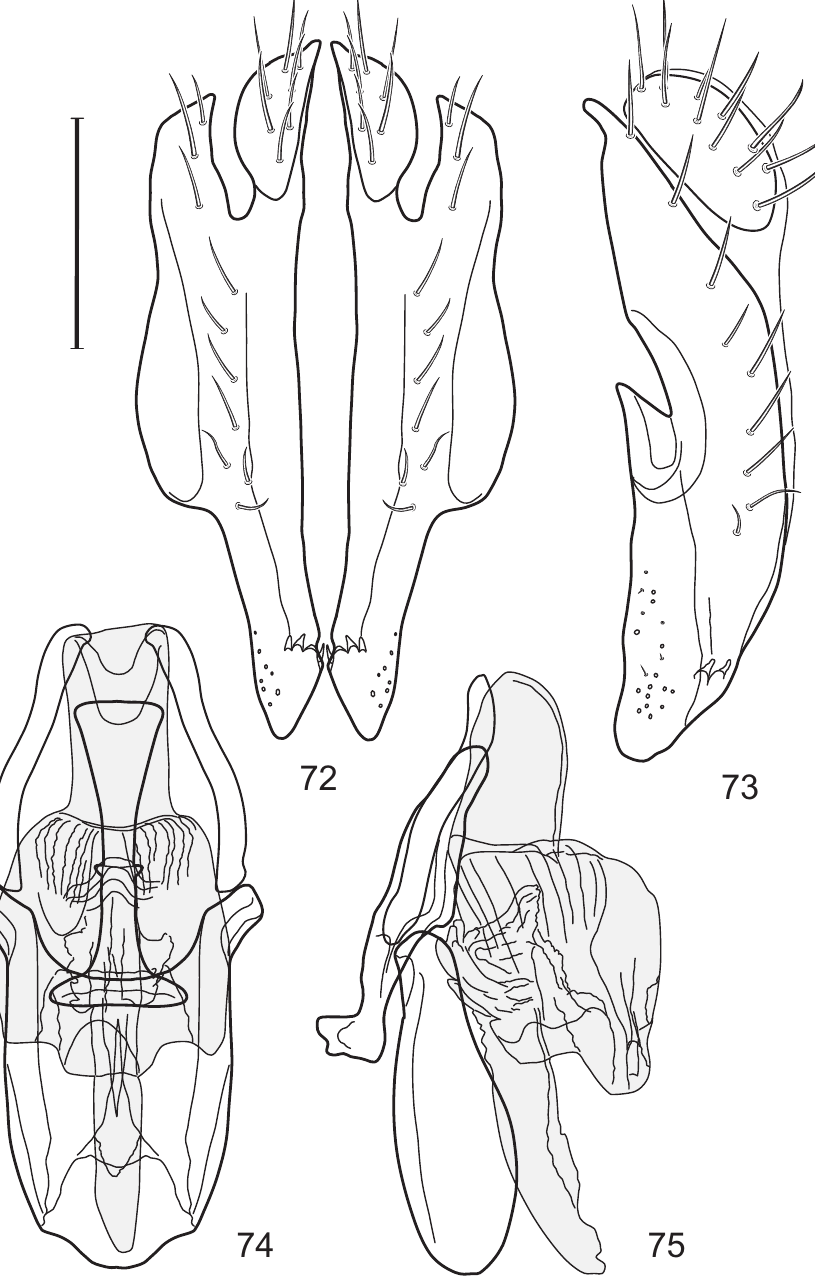
Figures 72–75. Hydrochasma distinctum sp. n. (Costa Rica. Limón: Parque Nacional Barbilla, Sector Casas Negras) 72 epandrium and cerci, posterior view 73 same, lateral view 74 internal structures of male terminalia (aedeagus [shaded], phallapodeme, gonite, hypandrium), ventral view 75 same, lateral view. Scale bar = 0.1